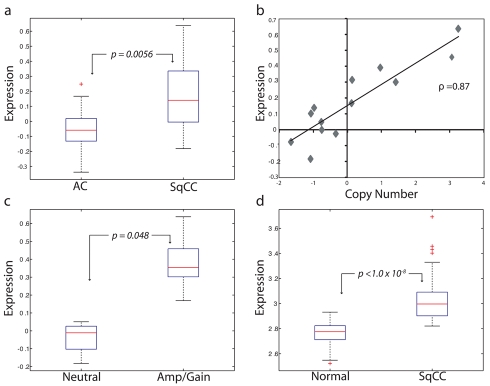

BRF2 is a lineage-specific oncogene targeted by amplification in SqCC.(A) Comparison of BRF2 mRNA expression values for AC (n = 34) and SqCC (n = 13) tumors (p = 0.0056). Box-plots depict the median group expression (red line), the 25th and 75th percentiles (blue box), and the limits of 95% of samples for each group (outside lines) with values for all other samples represented by red crosses. Expression values for all plots are in arbitrary log10 units. (B) Spearman's correlation of Z-transformed array CGH copy number ratios and expression values for BRF2 in 13 SqCC tumors (correlation coefficient = 0.87). Each diamond represents an individual sample. (C) Comparison of BRF2 expression between SqCC tumors with neutral copy number status (n = 4) and SqCC tumors with gain/amplification (n = 6) (p = 0.048). (D) Difference in BRF2 expression levels between 67 exfoliated bronchial cell samples from cancer-free patients and 53 SqCC tumors from an independent sample set (p<1.0×10−8).